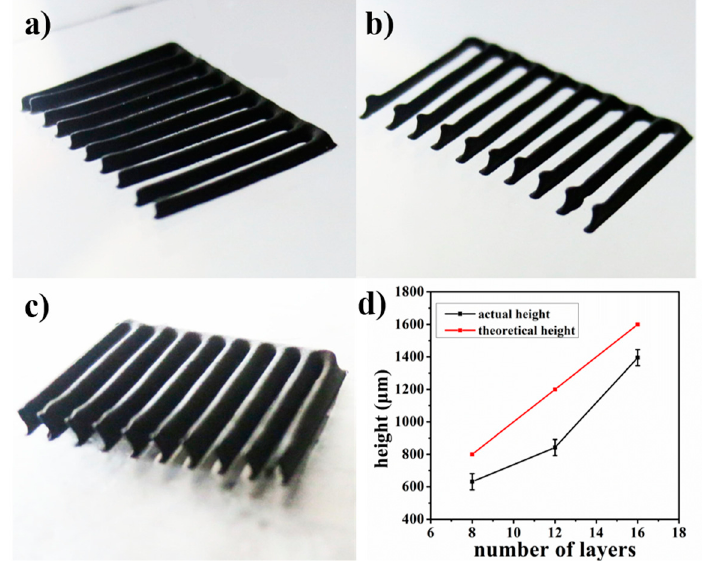
Figure 6. Printed comb-shaped LFP electrode: ( a ) 8 layers; ( b ) 12 layers; ( c ) 16 layers; ( d ) electrode height variation with number of layers.